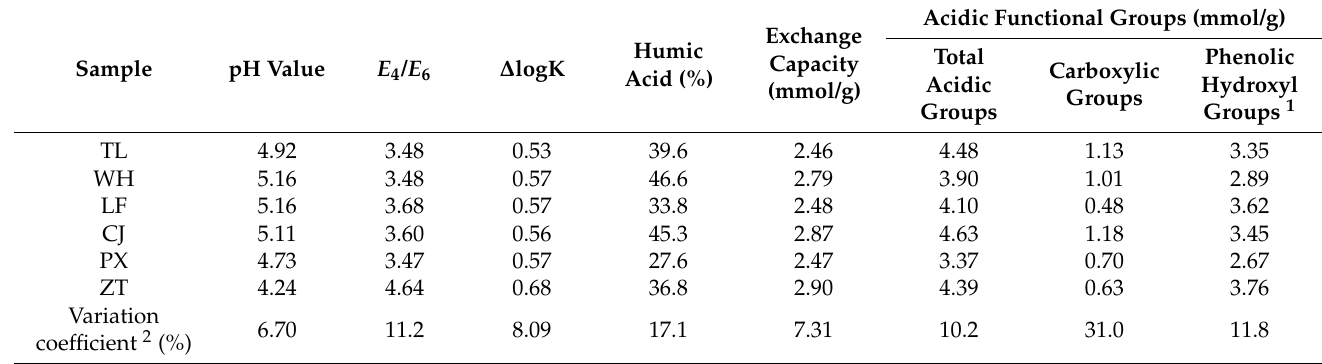
Table 2. Conventional chemical analysis of weathered coal samples from different geographic locations.